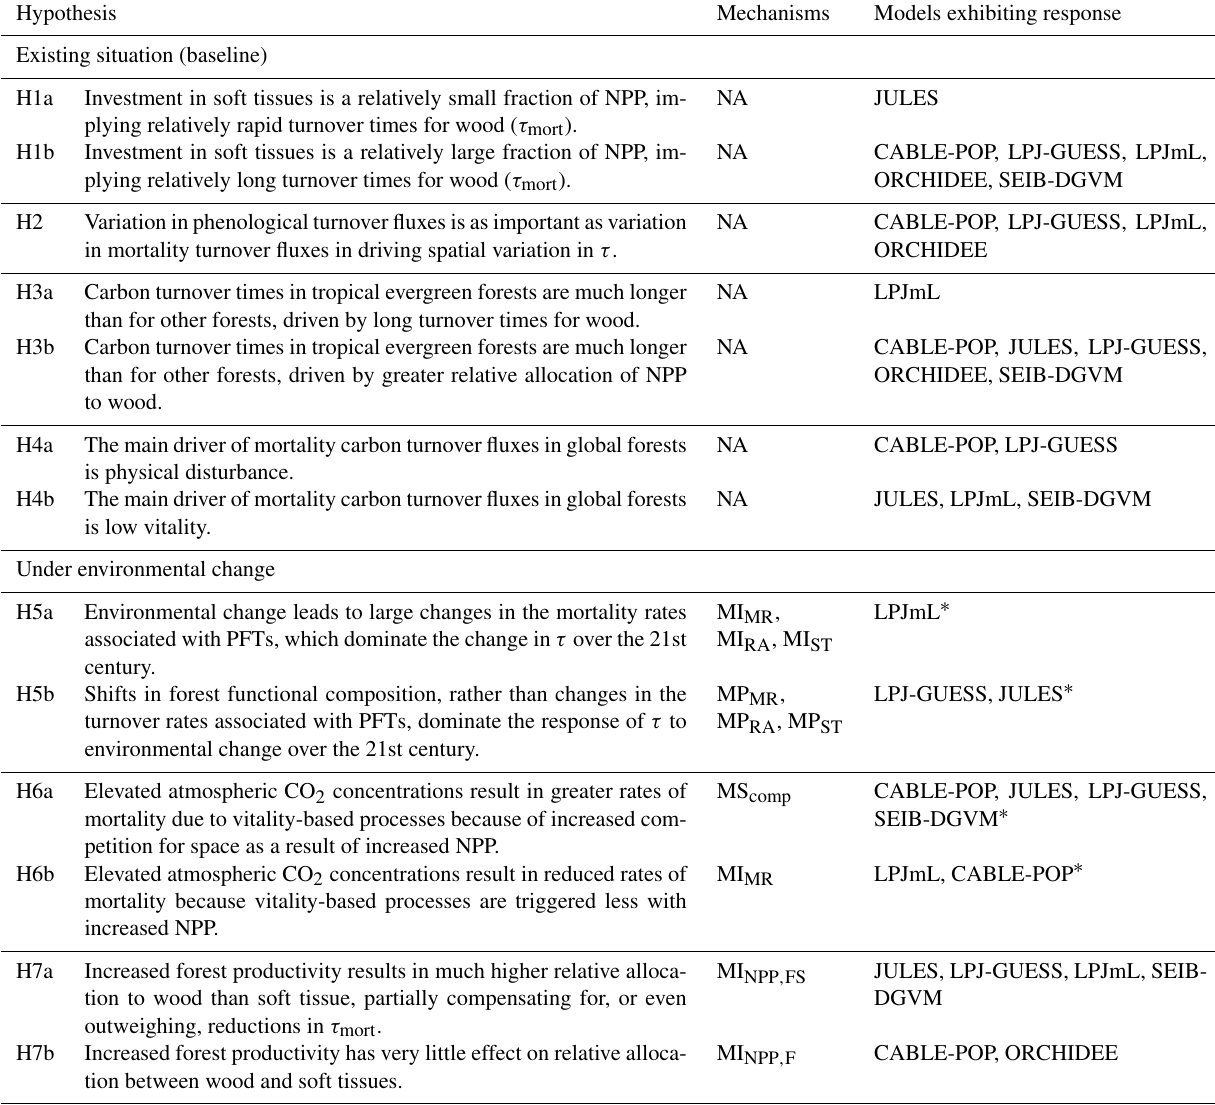
Table 5. Hypotheses resulting from the terrestrial biosphere models (TBMs) for controls on spatial and temporal variation in turnover time. Hypothesis Mechanisms Models exhibiting response Existing situation (baseline)